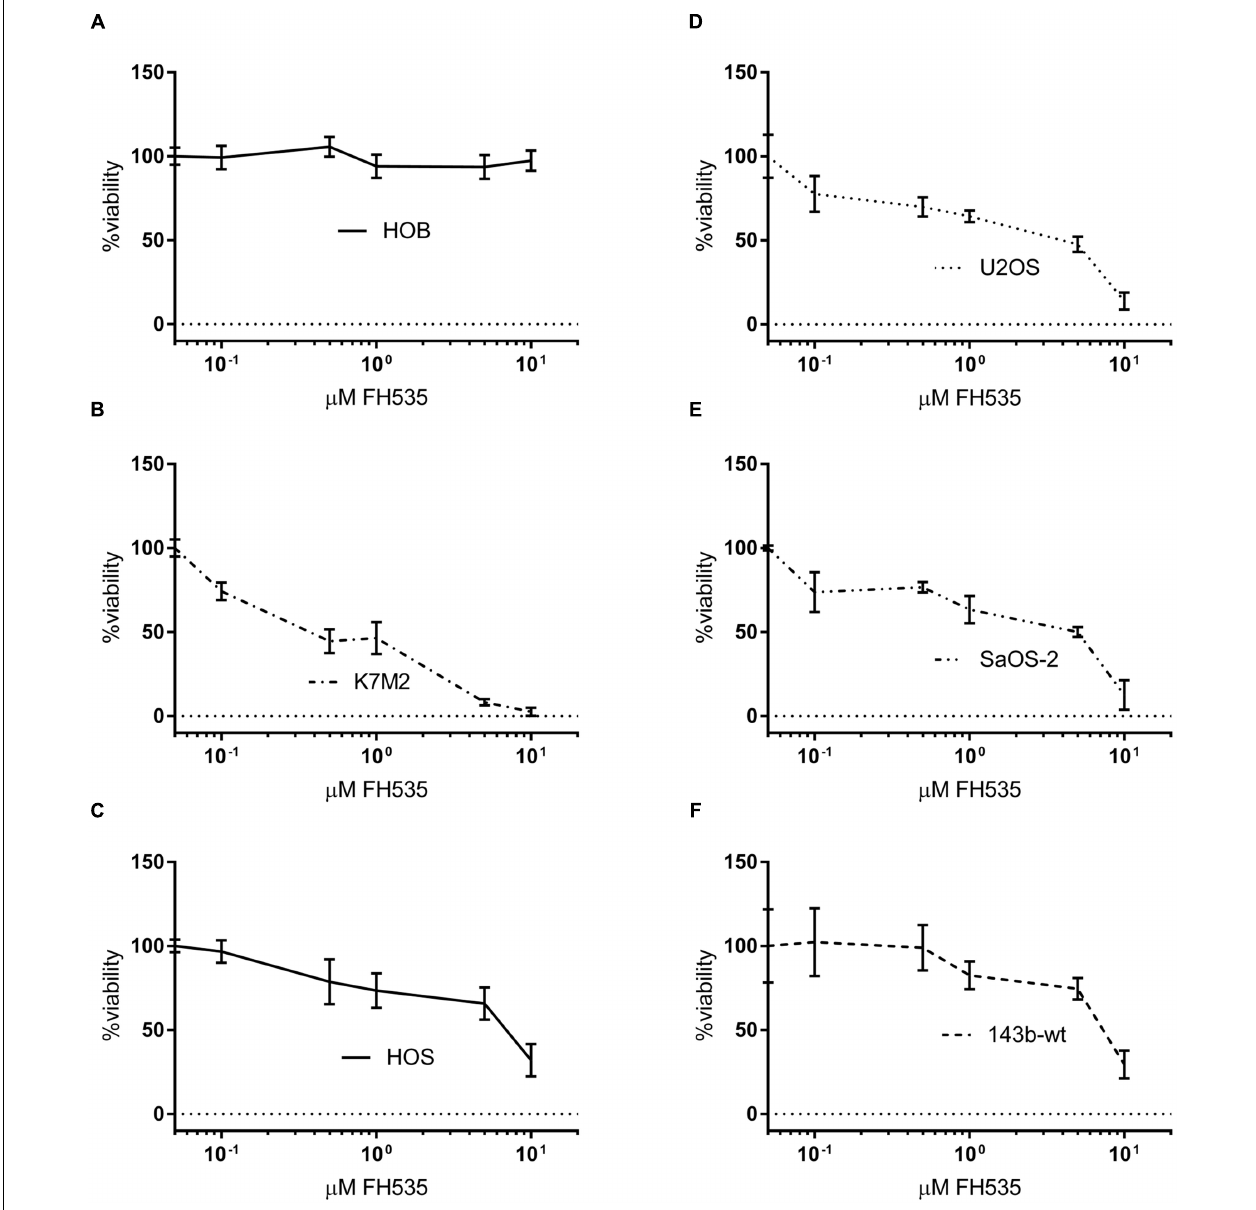
FIGURE 1 | FH535 is not toxic in human osteoblasts, but inhibits cell line viability in osteosarcoma cell lines (A–F) . Viability of human osteoblasts (A) or osteosarcoma cell lines after 48 h treatment with FH535. ( n = 3). Data information: in (A–F) , data are presented as mean, ± SD ( n = 3 for all groups).